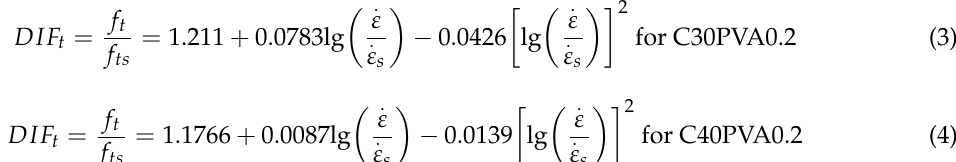
Figure 8. Two kinds of split tensile failure modes of FRC.